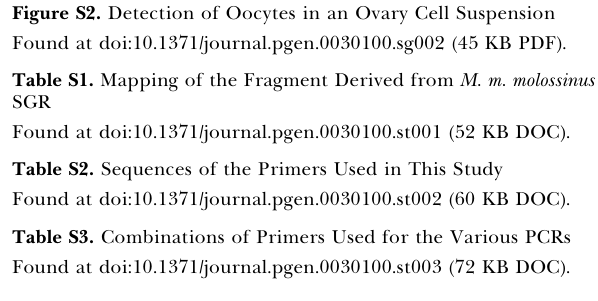
Figure S1. Example of the Parallel Detection of CO and NCO Figure S2. Detection of Oocytes in an Ovary Cell Suspension Table S1. Mapping of the Fragment Derived from M. m. molossinus in SGR Table S2. Sequences of the Primers Used in This Study Table S3. Combinations of Primers Used for the Various